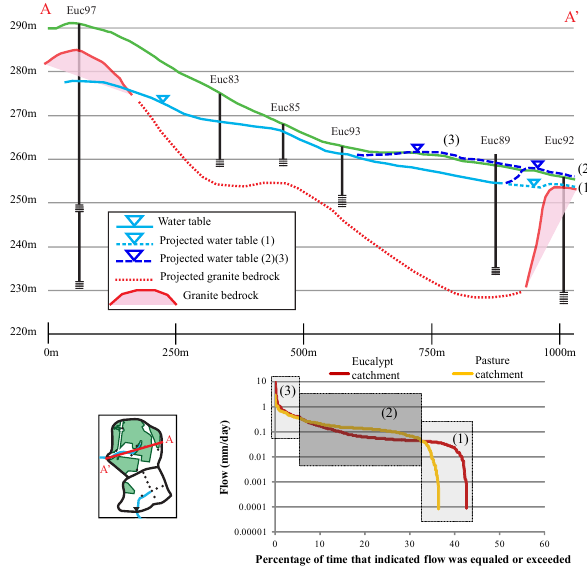
Figure 9. Long section from bores Euc97 to Euc92 showing the ef- fect of the shallow granite on the water table under different flow conditions shown in the flow duration curve below: (1) where low flows in the eucalypt catchment stream are sustained for longer due to some groundwater discharge compared to virtually no ground- water discharge in the pasture catchment, (2) where the water ta- ble is at the surface and runoff is transported more quickly out of the eucalypt than in the pasture catchment, and (3) where there are some rare, very high flows, much higher than observed in the pas- ture